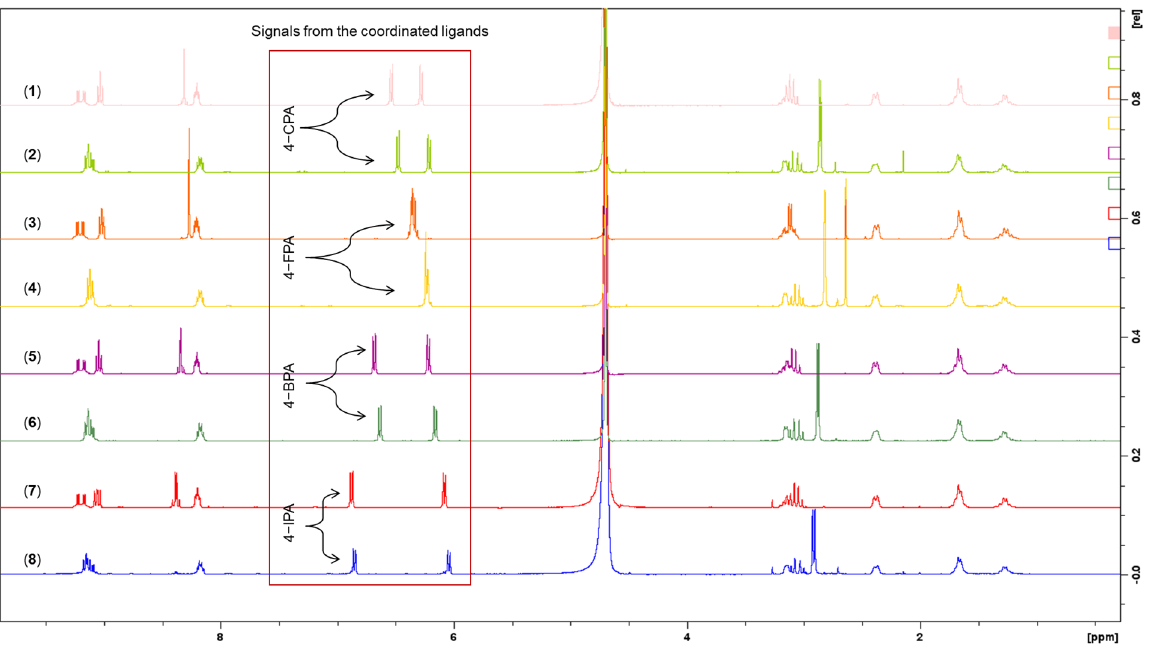
Figure 12. Stacked 1 H − NMR spectra of 1 – 8 highlighting the differences in splitting from the coordi- nated PAA ligands, in the region of 6–7 ppm.